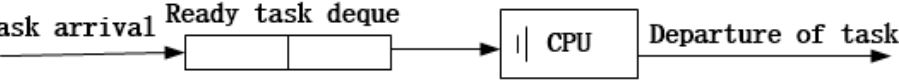
Figure 3. Fog computing node of M/G/1 model.